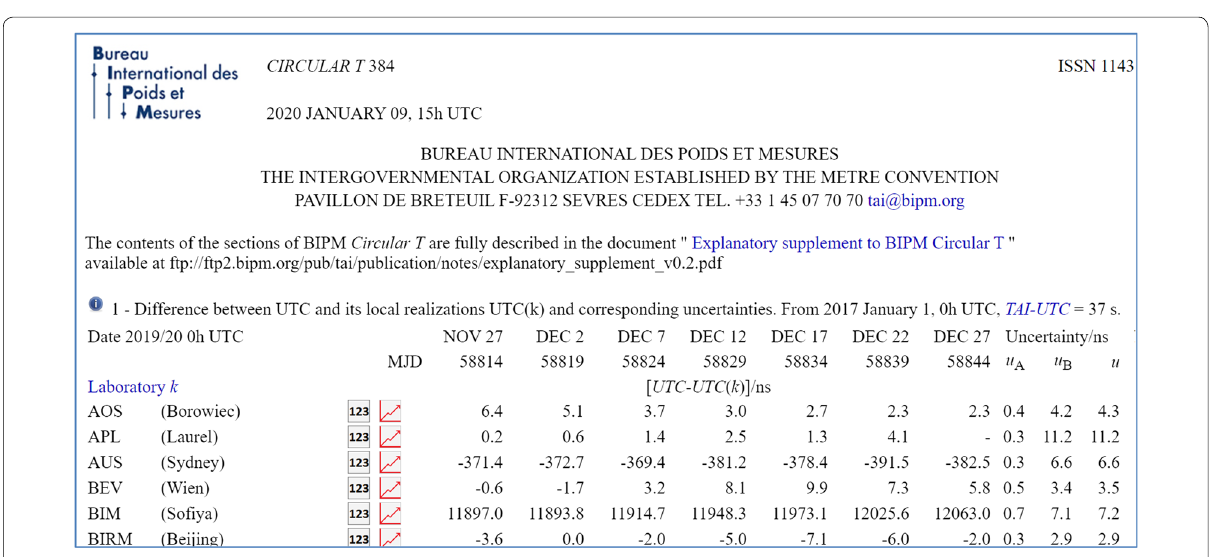
Fig. 9 An extract from the BIPM Circular T of Dec 2019 showing the differences UTC–UTC(k) on standard dates separated by 5 days. Details can be found here (https ://www.bipm.org/en/bipm-servi ces/times cales /time-ftp/Circu lar-T.html)